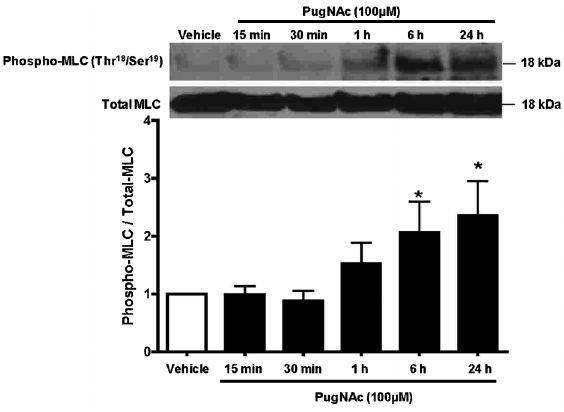
Figure 4. PugNAc-incubation produces a time-dependent increase in expression of phosphorylated myosin light chain (MLC) in vascular smooth muscle cells (VSMCs). VSMCs cultured from rat thoracic aortas were incubated with PugNAc at different times (15, 30 min, 1, 6, or 24 h). Western blot analysis was performed to evaluate expression of phosphorylated MLC in comparison to VSMCs that were incubated with vehicle (methanol, for 24 h). Data are reported as means±SE of the relative expression of the phosphorylatedformofMLC (Thr 18 /Ser 19 ) after normalization tothe corresponding total protein expression (n=6). *P , 0.05 vs vehicle (10 m L/mL methanol, vehicle to PugNAc) (Student t